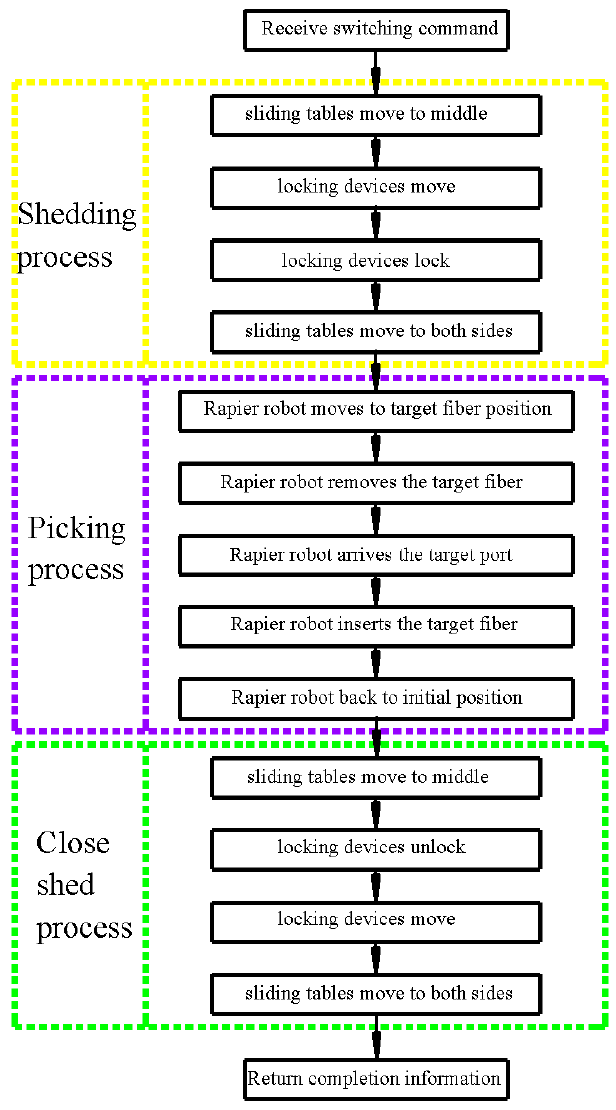
Figure 14. Automatic optical distribution frame (AODF) working flow Figure 14 . Automatic optical distribution frame (AODF) working flow chart.